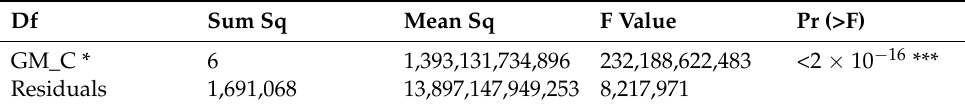
Table 3. Calculation of η 2 values in the analysis of variance (ANOVA).